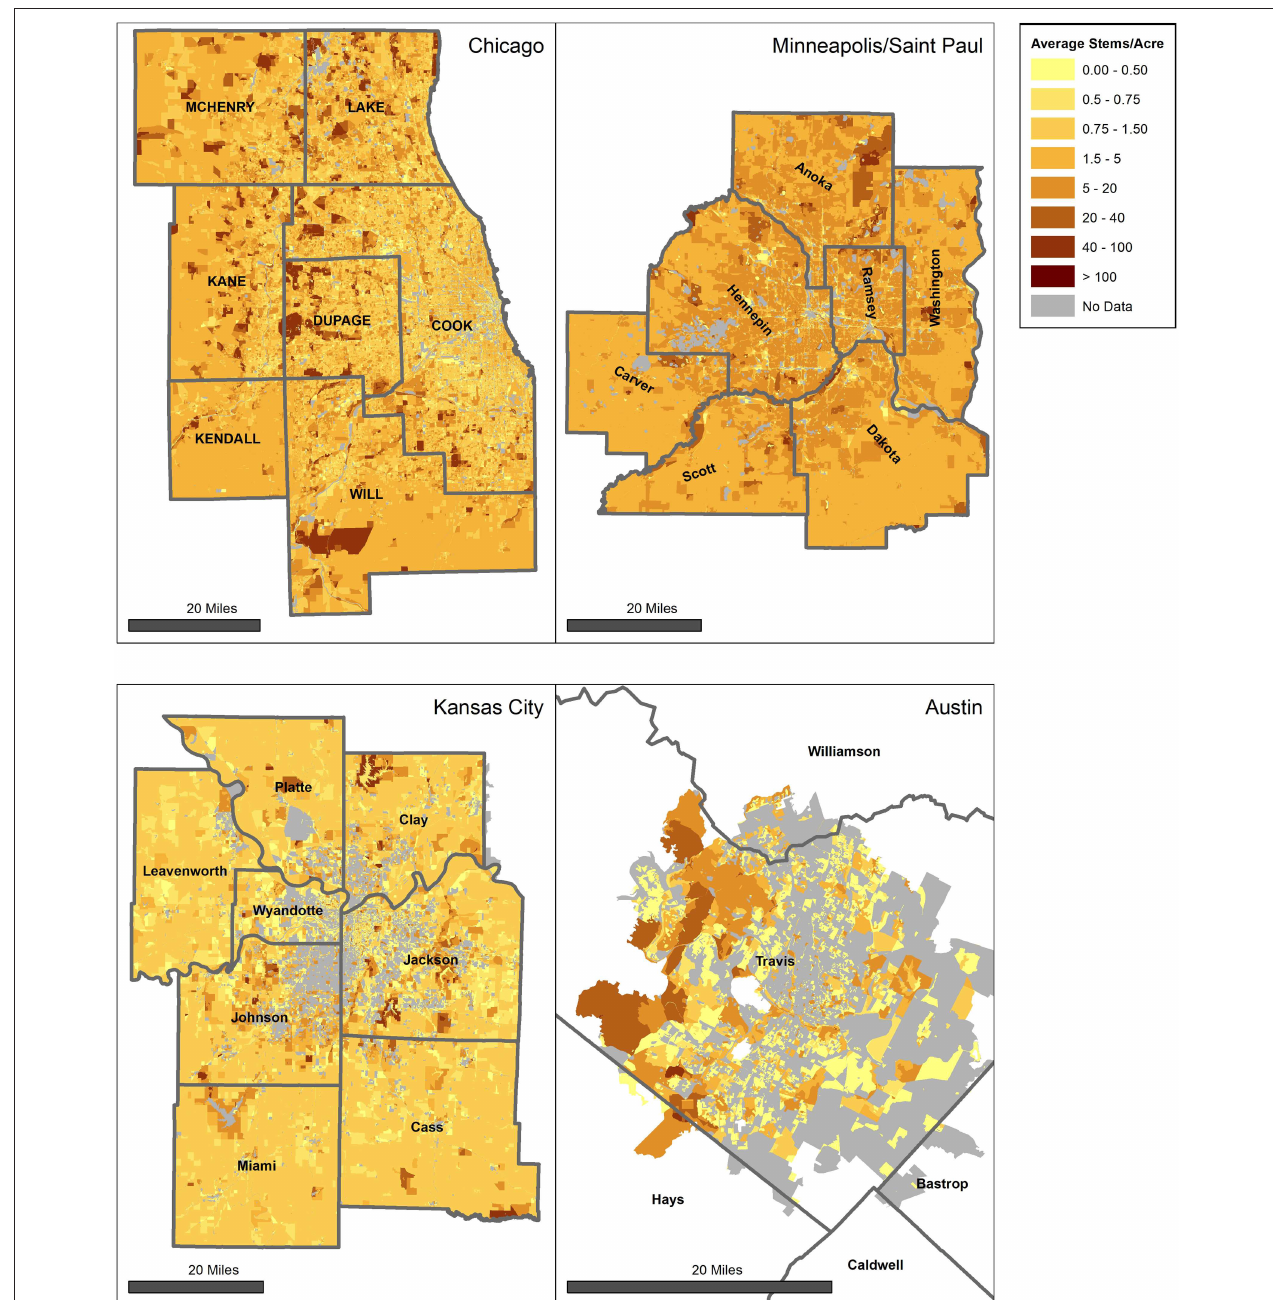
FIGURE 10 | Baseline average milkweed densities by US census blocks for all four metropolitan areas. Darker areas indicate a higher milkweed density than lighter areas. The highest observed densities for all four metropolitan areas were in natural areas. These natural areas are more present and evenly dispersed within the 7 counties that make up Chicago’s metropolitan area. Limitations in available land use data and sampling resulted in areas within the analysis extent where there was no calculated milkweed densities, shown in